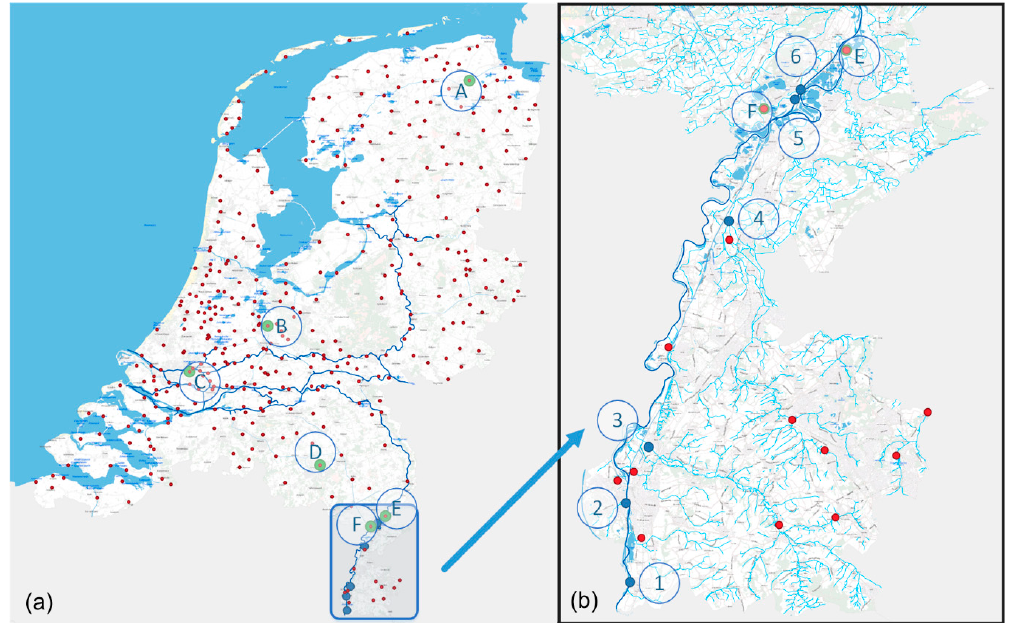
Figure 1. ( a ): Wastewater treatment plants (WWTPs) in The Netherlands (red dots) and WWTPs sampled for effluent characterization (green-red dots, indicated A to F); ( b ): Sample locations in surface water bodies (blue dots, indicated 1 to 6) in the southern part of the province of Limburg.